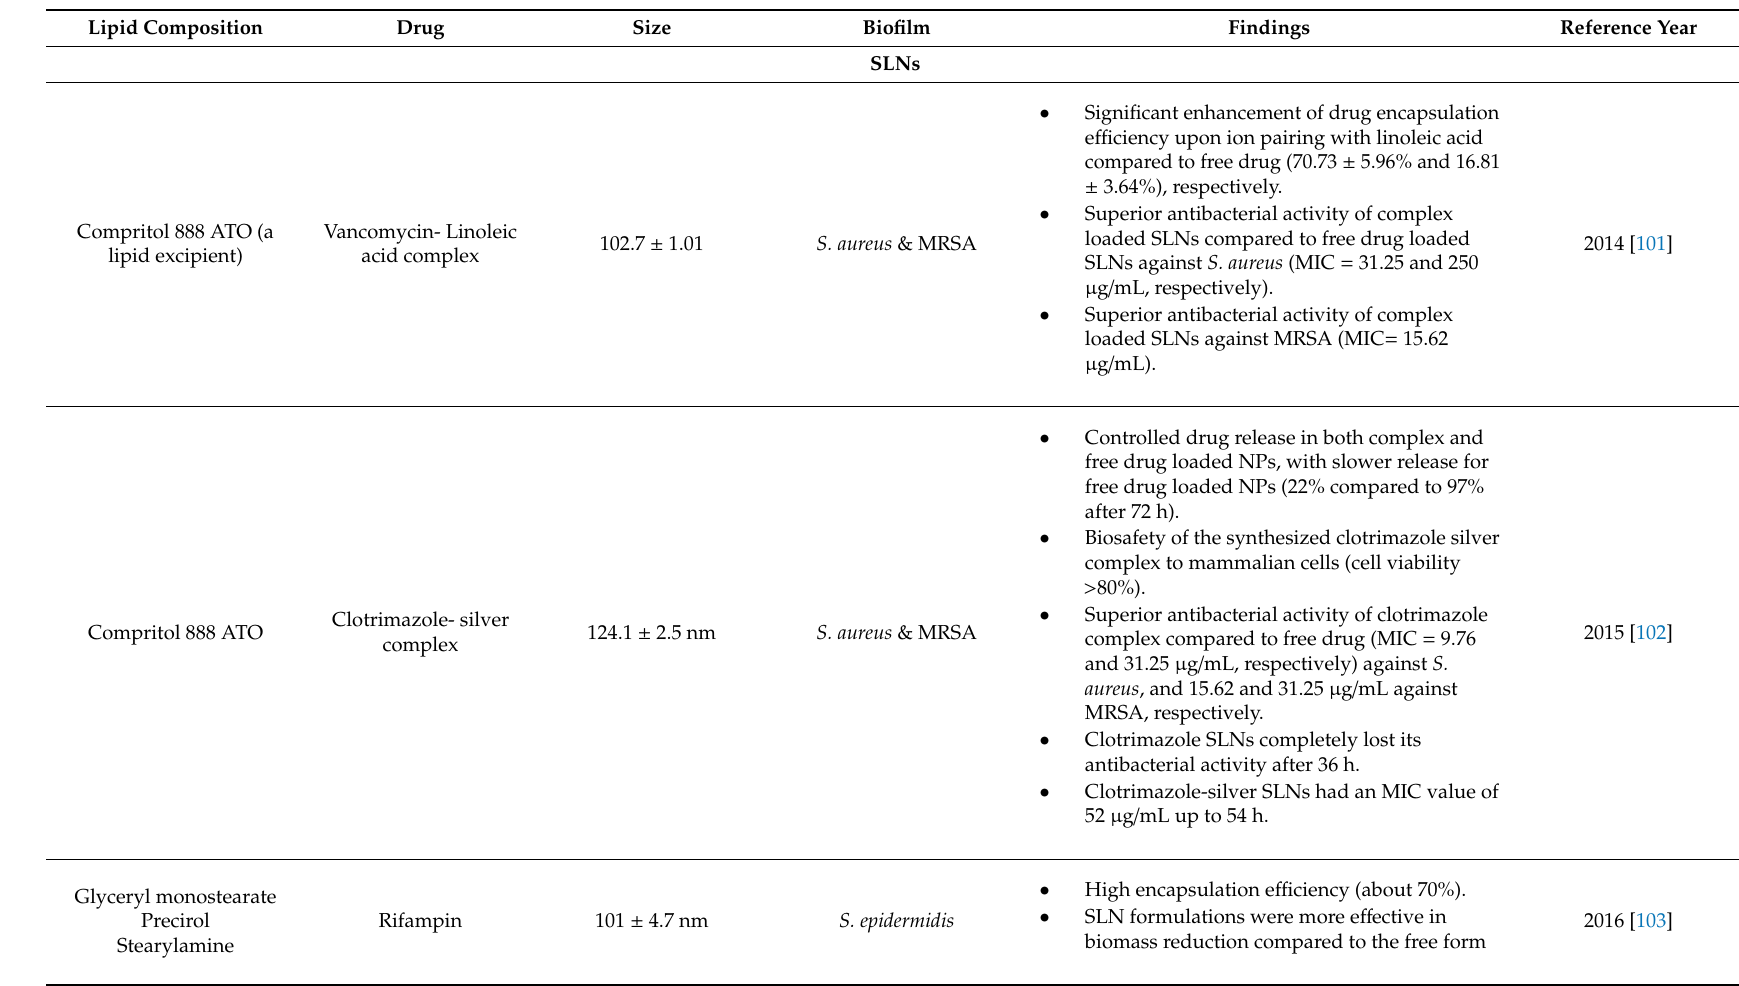
Table 2. Examples on recent studies on lipid-based nanoparticles against bacterial